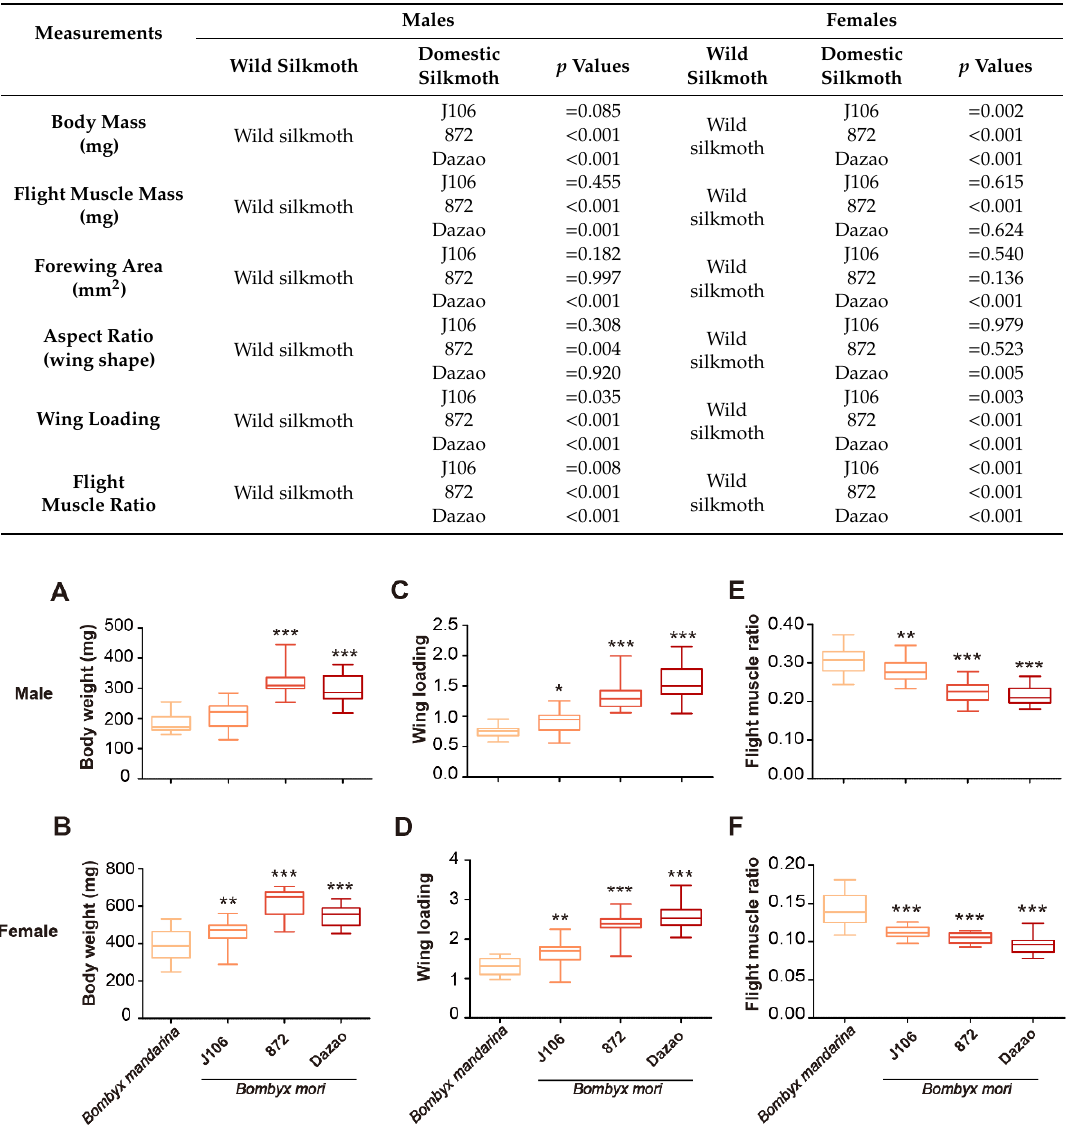
Table 3. One-way ANOVA tests were conducted separately for males and females. The table shows Tukey’s comparison between B. mandarina and each of the three B. mori populations, respectively. The significance level is 0.05 (Tukey HSD post hoc tests).